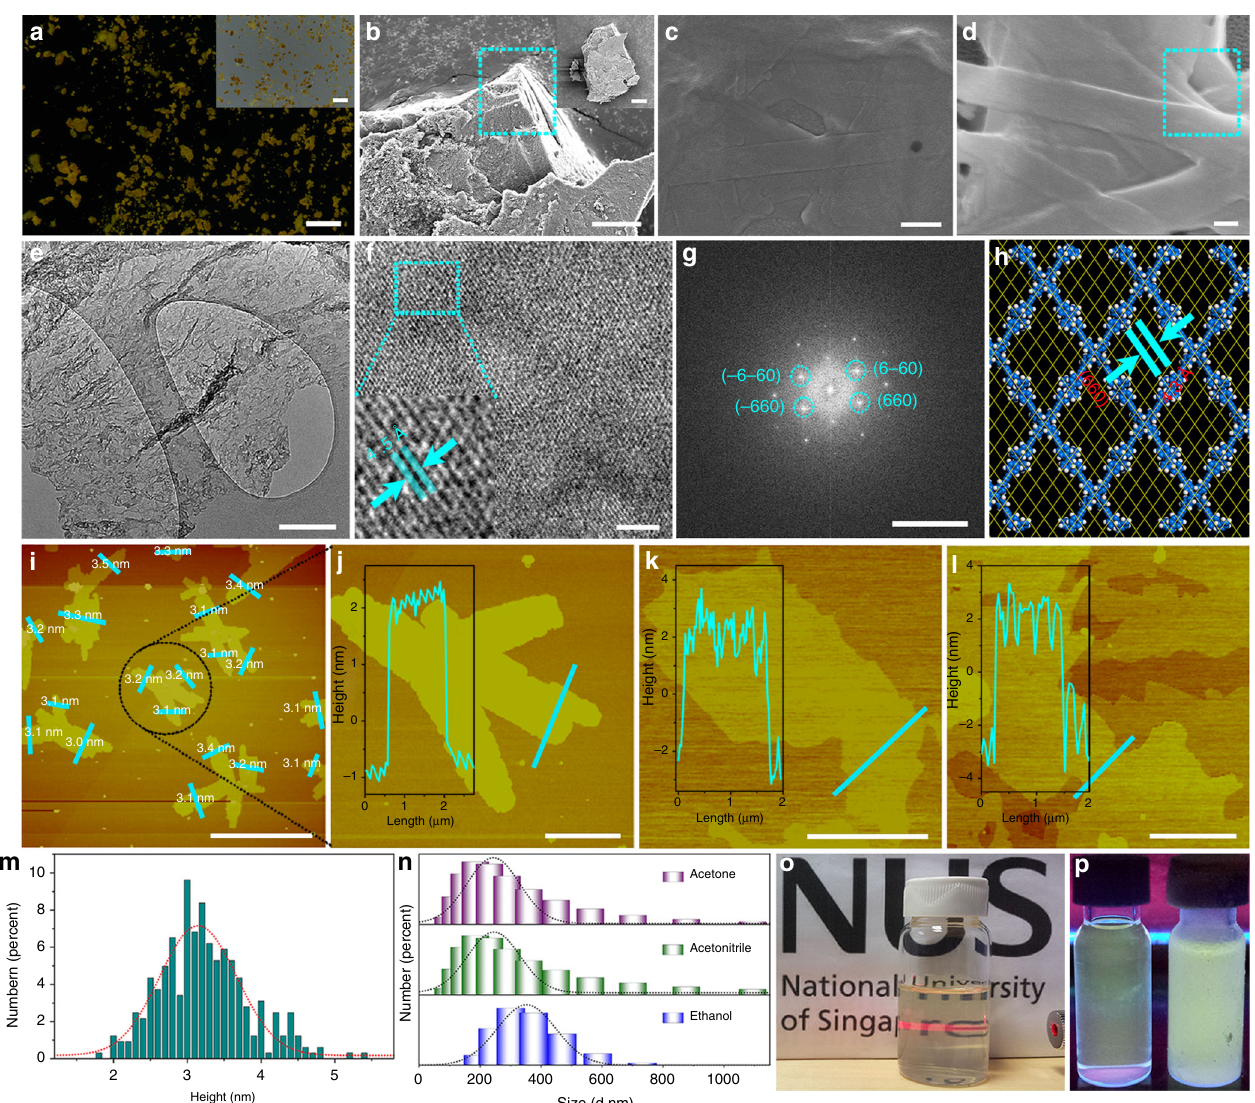
Fig. 3 Morphology characterization of NUS-24 nanosheets. a Fluorescence photograph of NUS-24 bulk powder (scale bar, 3 mm. λ ex = 365 nm). Inset of a corresponding optical photograph (scale bar, 3 mm). b FE-SEM image of NUS-24 bulk powder (scale bar, 10 μ m. scale bar of inset of b , 30 μ m). c , d FE- SEM images of NUS-24 nanosheets deposited on AAO substrate (scale bar, 500 nm in c and 200 nm in d ). The circulated rectangular areas indicate the 2D layered structure of NUS-24. e TEM image of NUS-24 nanosheets (scale bar, 200 nm). f HR-TEM image of NUS-24 nanosheets featuring the planar lattice structure (scale bar, 5 nm. Inset: the lattice distance). g The fast Fourier transformation of f (scale bar, 5 1 per nm). h The lattice structure from (660) plane of the optimized NUS-24 crystal structure. i – l AFM images of NUS-24 nanosheets dispersed in acetone ( i , j ), acetonitrile ( k ), or ethanol ( l ) (scale bar, 10 μ m in i and 2 μ m in j – l . Inset: the height of AFM image for selective area). m The statistical height distribution of NUS-24 nanosheets based on 322 AFM measurements. n The DLS results of NUS-24 nanosheets in different solutions. o The optical photograph of NUS-24 nanosheets in acetone solution indicating strong Tyndall effect. p The fl uorescent photograph of NUS-24 nanosheets in acetone solution at 298 K (left, solution state) and 77 K (right, solidi fi ed state) ( λ ex = 365